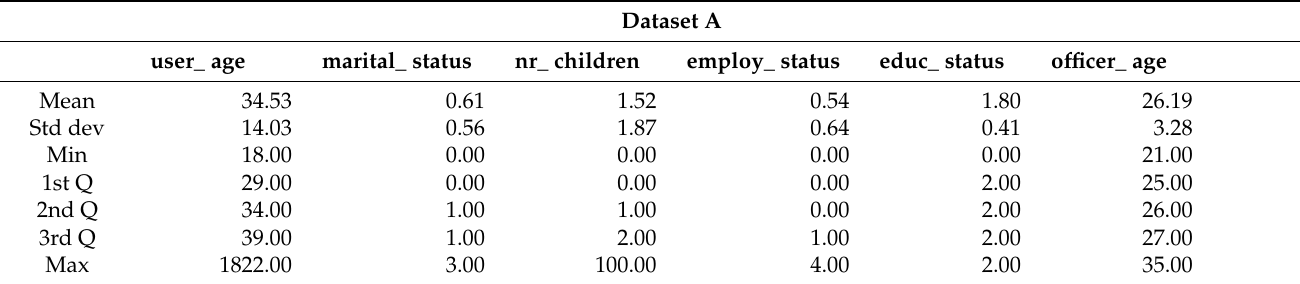
Table 2. Table of descriptive statistics for dataset A.